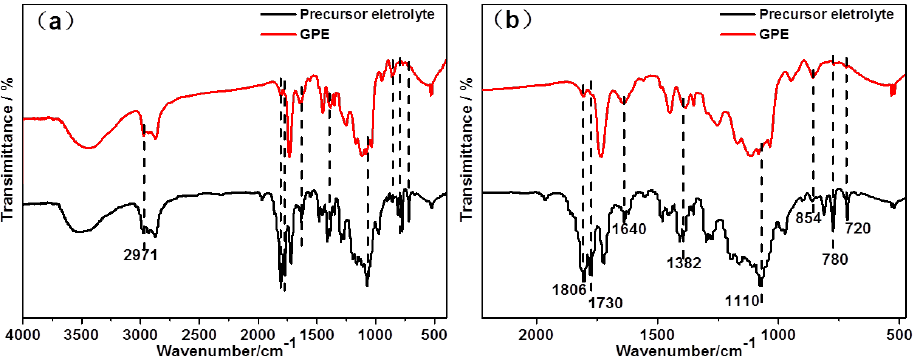
Figure 4. FTIR spectra of LiBF 4 -EOEOEA 30% precursor electrolyte and LiBF 4 -EOEOEA 30% GPE.